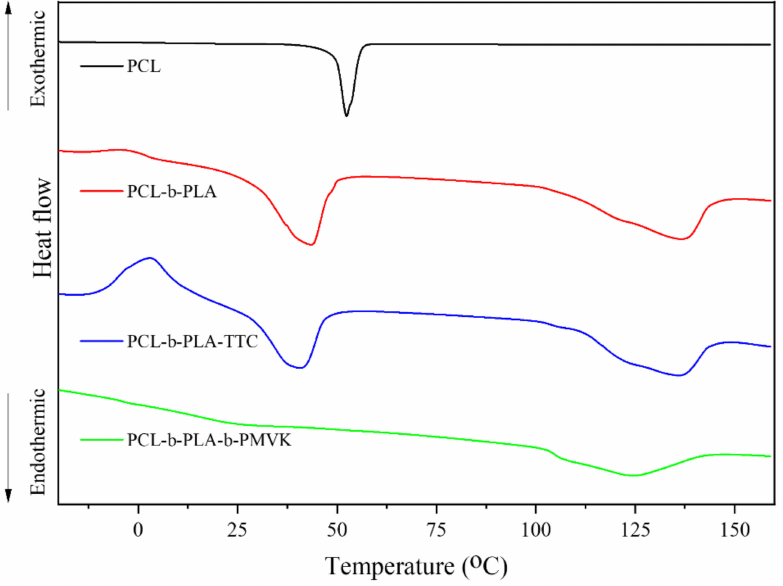
Figure 6. DSC thermogram of PCL, PCL-b-PLA, PCL-b-PLA-TTC, and